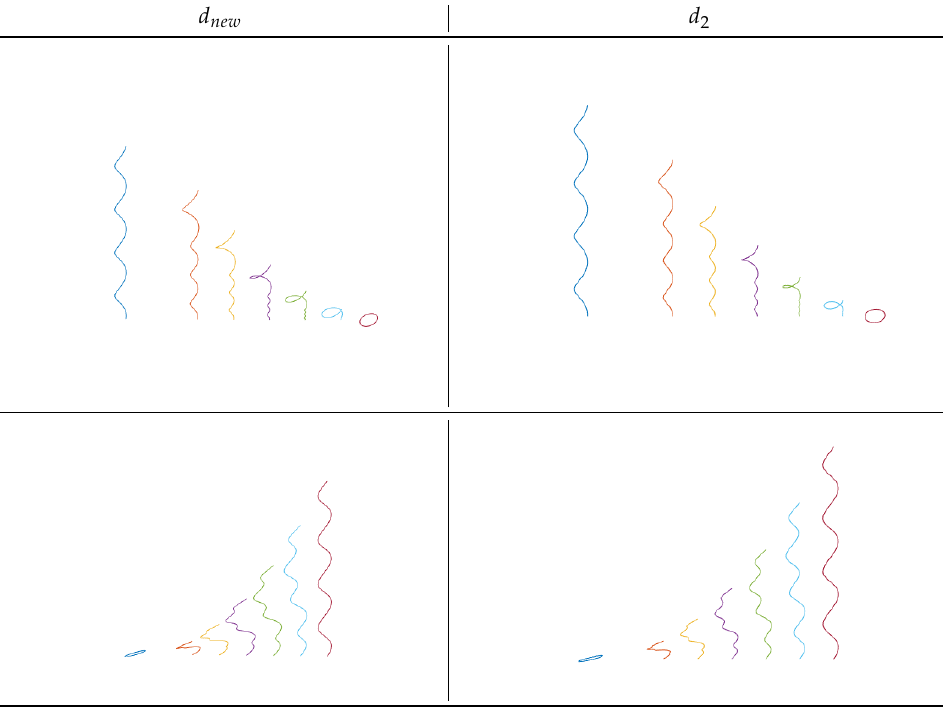
Figure 3. Comparison of the geodesic obtained using the two different distances.